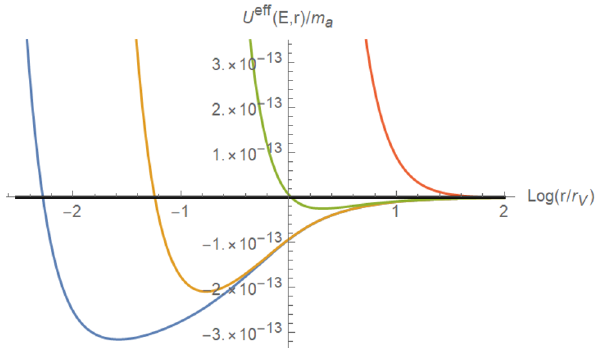
Figure 3 . Plot of the effective potential for (cid:15) GV = 10 − 11 (which corresponds to Λ = 10 − 12 eV and a mass m = 10 6 M (cid:12) ), (cid:15) V b = 10 − 2 , and m b /m a = 10 − 2 . The blue line correspond to (cid:15) pm (cid:15) M = 10 − 21 . For the other color lines, (cid:15) pm (cid:15) M increases by two orders of magnitude from left to right. The thick black line is (cid:15) pm (cid:15) M , thus the intersection of the color lines with the black line gives r min . Note that these potentials were computed using the exact solution eq. (4.33), so they are valid both inside and outside Vainshtein